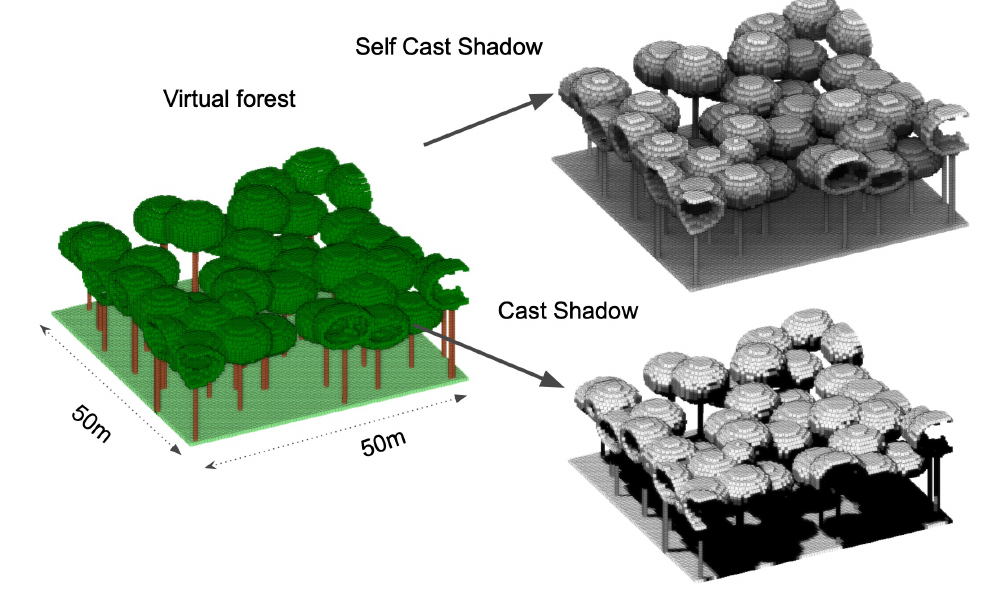
Figure 5. Schematic illustration of the virtual forest scene.